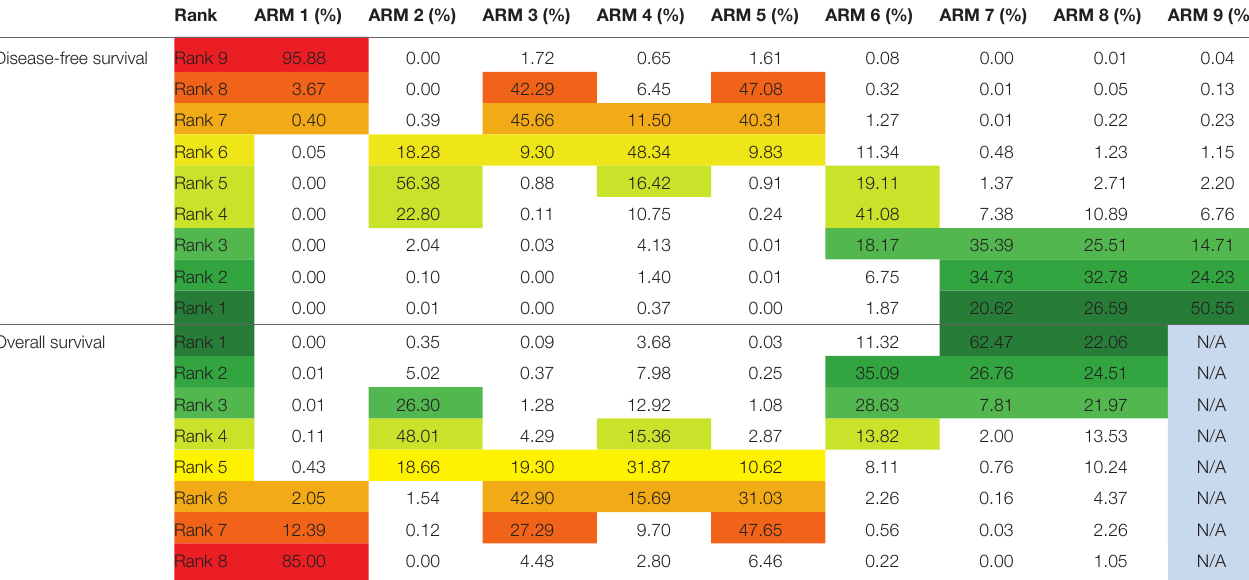
TABLe 1 | OS and DFS rankings for the (neo)adjuvant treatment strategies available for early and locally advanced HER2 + breast cancer. a